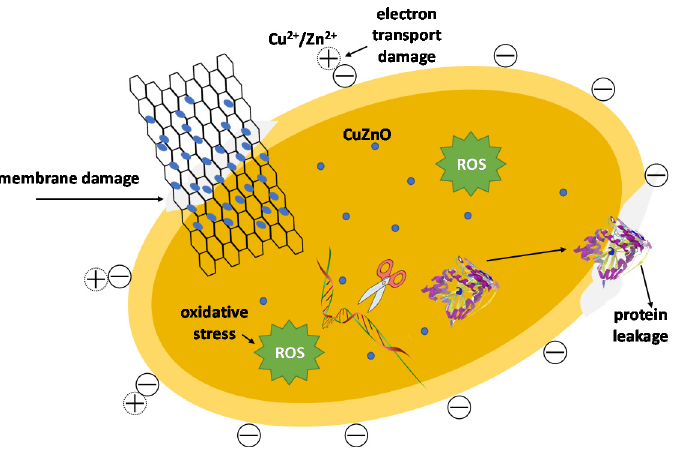
Figure 14. Antibacterial mechanism of CuZnO@RGO nanocomposites, drawn based on reference [123].